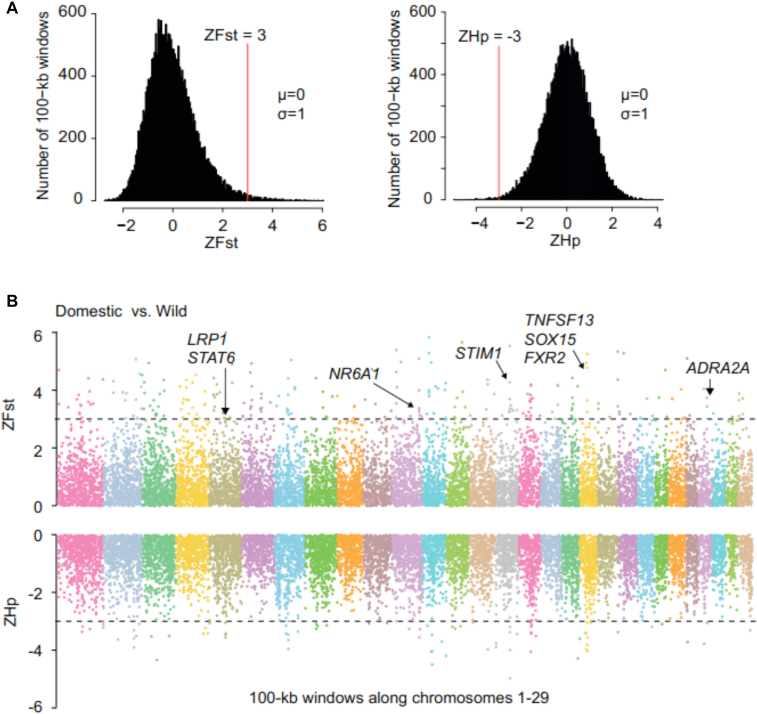
Candidate regions for DAGs. (A) Distribution of Z-transformed pooled heterozygosity (ZHp) in 15 domestic goats, and Z-transformed fixation index (ZFst) between wild and domestic goats for autosomes 1 to 29. Red vertical lines indicate thresholds. (B) Positive end of ZFst distribution (ZFst >3) and negative end of ZHp distribution (ZHp<-3) used for extracting outliers. Dashed lines indicate cutoff values. DAGs labeled are discussed in the text.